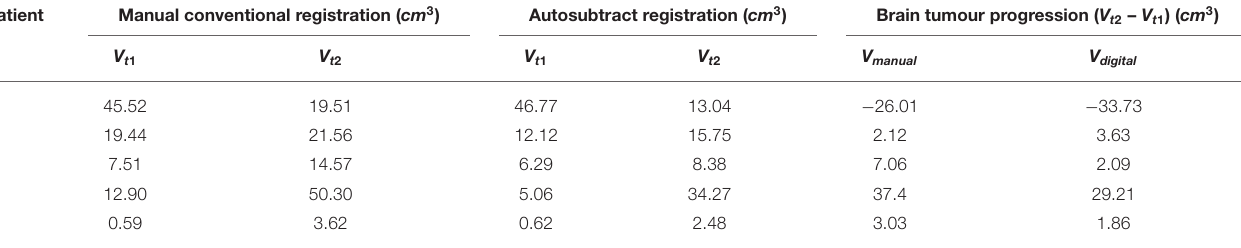
TABLE 4 | Comparison of tumour volume between manual conventional reading and digital image subtraction technique that determines the brain tumour progression. Patient Manual conventional registration ( cm 3